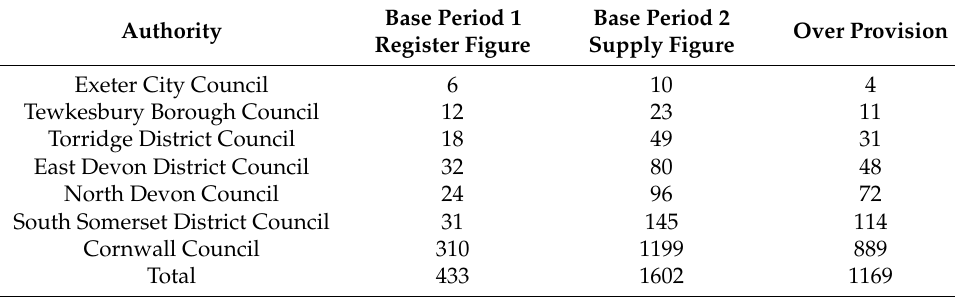
Table 14. Base period two over provision in the study area.